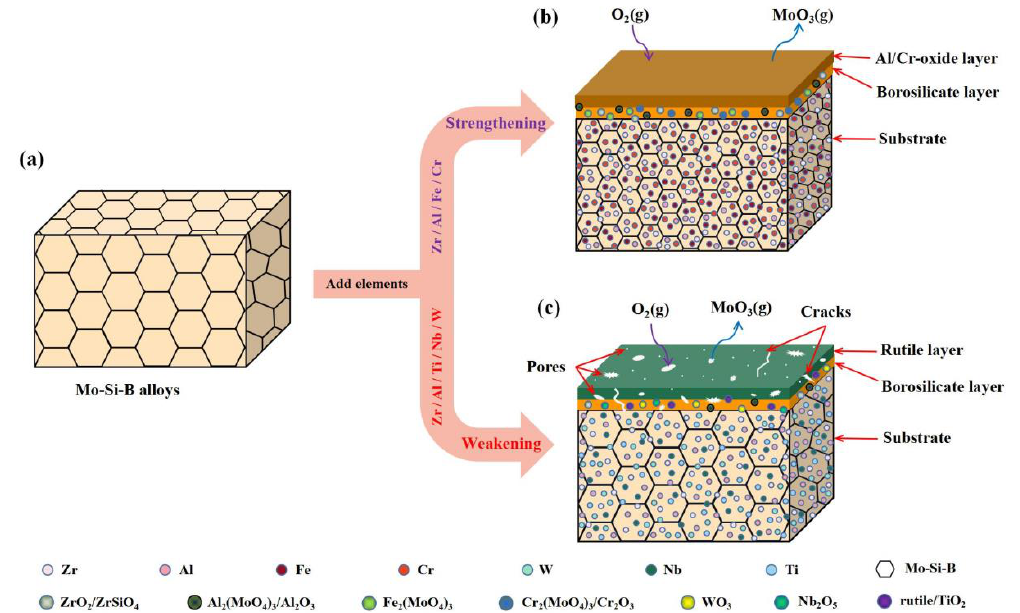
Figure 20. The schematic diagram of modification mechanism of metal elements. ( a ) Mo-Si-B alloys before oxidation ( b ) Strengthening ( c ) Weakening.